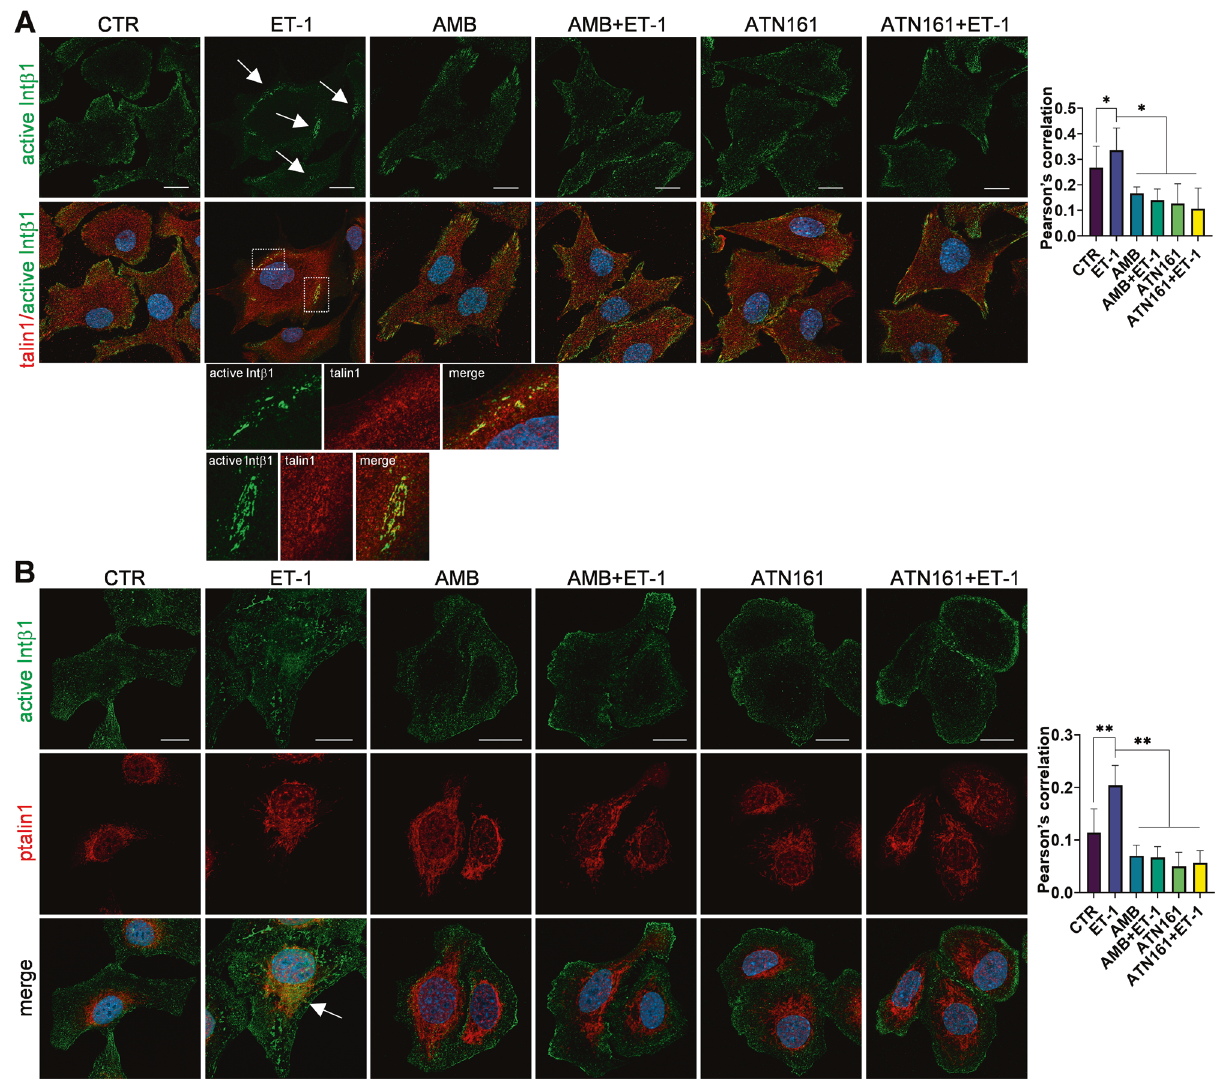
Fig. 4 ET-1 promotes the phosphorylation of talin1 and its association with active Int β 1. A CLSM analysis of SKOV3 cells stimulated with ET-1 for 5 min and/or AMB and/or ATN161, then stained for active Int β 1 (green) and talin1 (red) detection. Colocalization is shown in merged images, detected in yellow. For ET-1 stimulation, intracellular accumulation of active Int β 1 is depicted by arrows and higher-power magni fi cation images of two selected ROI are shown, bringing out active Int β 1/talin1 colocalization. Nuclei are reported in blue (DAPI). Scale bar, 20 μ m. Columns show the mean ± SD of quanti fi cation of Pearson ’ s correlation between active Int β 1 and talin1. B CLSM analysis of SKOV3 cells stimulated with ET-1 and/or AMB and/or ATN161 for 5 min and stained for active Int β 1 (green) and ptalin1 (red). Colocalization is shown in merged images, detected in yellow and depicted by an arrow. Nuclei are reported in blue (DAPI). Scale bar, 20 μ m. Columns, mean ± SD of quanti fi cation of Pearson ’ s correlation between active Int β 1 and ptalin1. n = 3, one-way